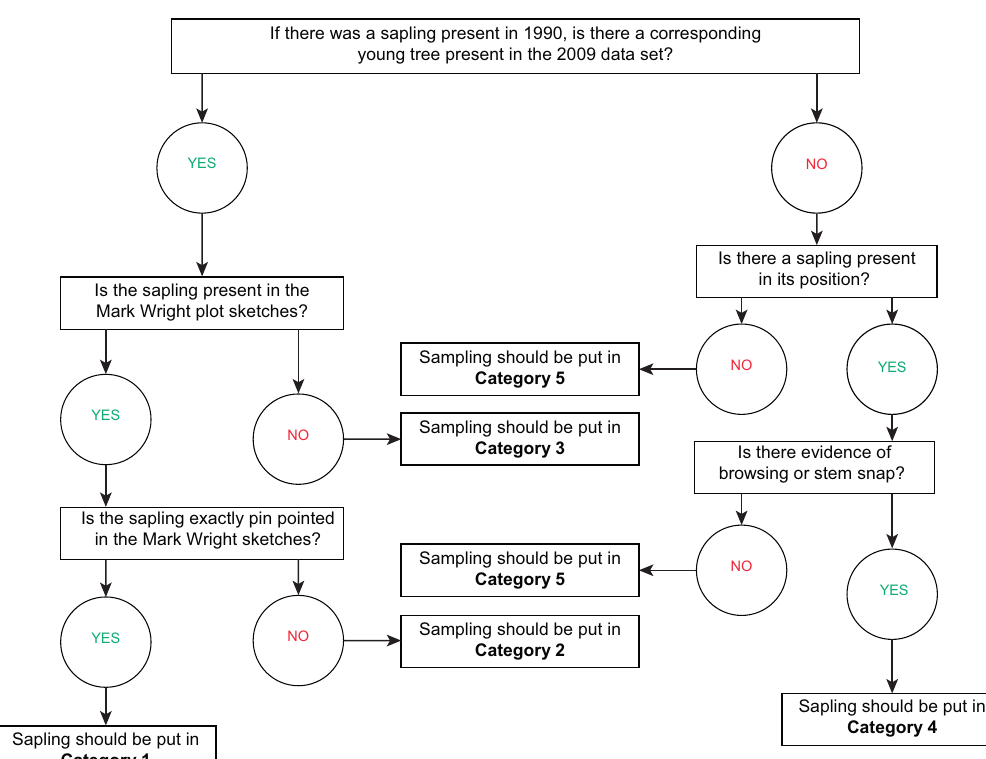
Figure 2. The decision tree used to assign saplings to